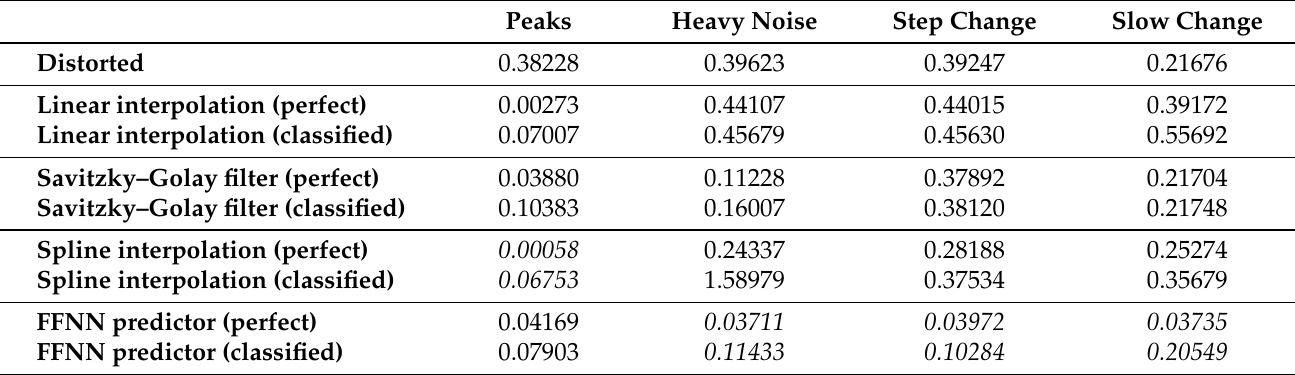
Table 5. RMSE after reconstruction with different methods (with perfect and algorithmic artifact classifications) for the mocap sequence with a 20% distorted time in the